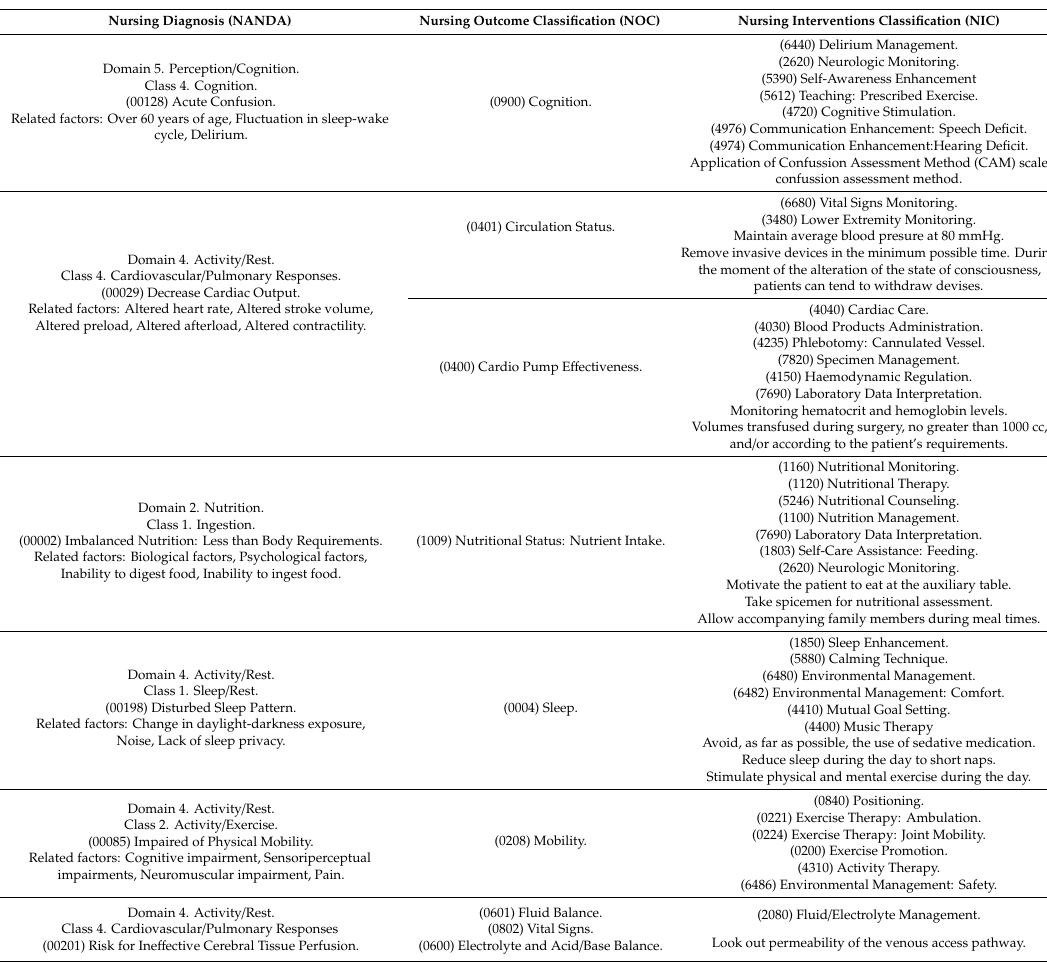
Table 4. Nursing Care Plan for the management of delirium to elderly adults in postoperative. NursingDiagnosis(NANDA) NursingOutcomeClassification(NOC) NursingInterventionsClassification(NIC) Domain5. Perception / Cognition. Class4. Cognition.